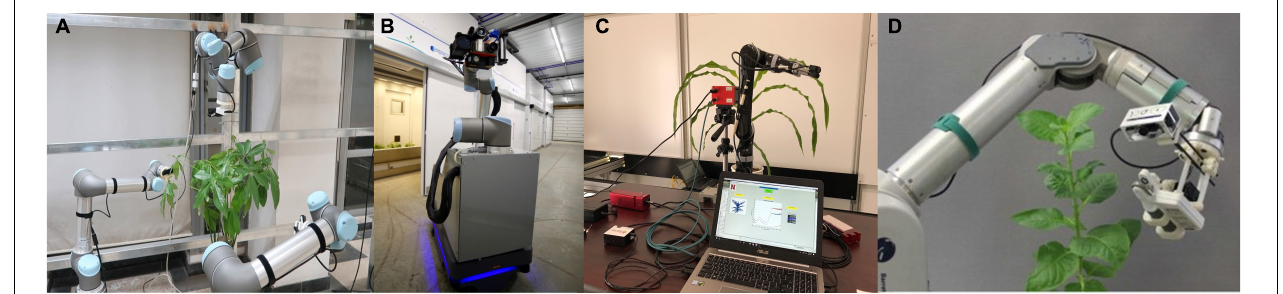
FIGURE 1 | Plant phenotyping robotic systems for indoor environment: (A) A multi-robot system equipped with deep learning technique to determine optimal viewpoints for 3D model reconstruction (Wu et al., 2019), (B) Sensor-equipped robot to measure the reflectance spectra, temperature, and fluorescence of leaf (Bao et al., 2019c), (C) Robotic system to measure leaf reflectance and leaf temperate (Atefi et al., 2019), and (D) Robotic system for direct measurement of leaf chlorophyll concentrations (Alenyá et al.,